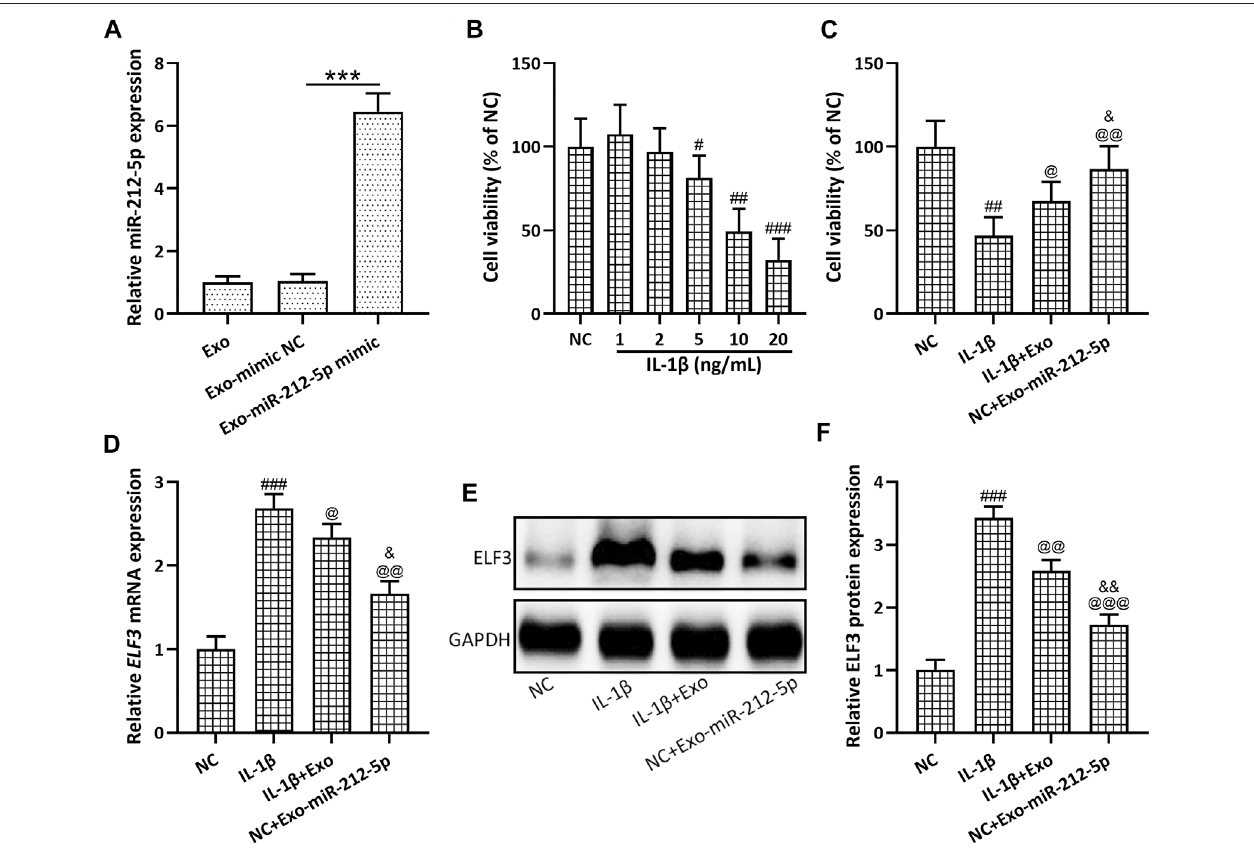
FIGURE 4 | Exosomes derived from miR-212-5p overexpressed SMSCs (SMSC-212-5p-Exos) inhibited up-regulated ELF3 expression in chondrocytes induced by IL-1 β . (A) qRT-PCR was utilized to analyze the relative expressions of miR-212-5p from SMSC-Exos or SMSC-212-5p-Exos. (B) Cell viability of chondrocytes after individual treatment with different concentrations of IL-1 β for 48 h. (C) Cell viability of chondrocytes after co-treatment with IL-1 β and SMSC-Exos, or SMSC-212-5p- Exos for 48 h. (D – F) IL-1 β induced chondrocytes were treated with SMSC-Exos or SMSC-212-5p-Exos for 48 h qRT-PCR and western blotting were used to analyzethemRNAandproteinsexpressionsofELF3. n =6foreachgroupincellviabilityanalysis, n =3foreachgroupinqRT-PCRandwesternblottingtests.# p < 0.05, ## p < 0.01, ### p < 0.001 compared to NC. @ p < 0.05, @@ p < 0.01, @@@ p < 0.001 compared to IL-1 β . & p < 0.05, && p < 0.01 compared to IL-1 β +Exo. One-way ANOVA followed Dunn ’ s multiple comparisons